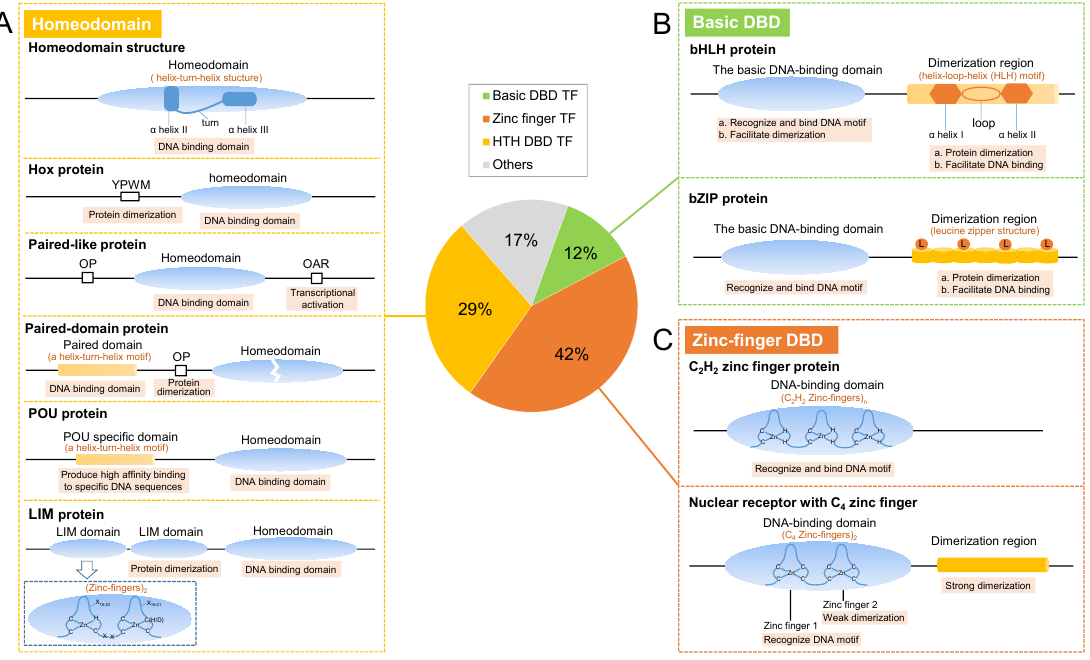
Figure 2. The main structures of insect TFs. The pie chart represents the statistical ratio of the Drosophila TFs in different superclasses based on Hammonds’ study [22]. ( A ) Structures of homeodomain TFs. Homeodomain: a typical homeodomain contains a short N-terminal arm facilitating DNA binding and four α -helices with a helix II-turn-helix III structure that is responsible for DNA binding and recognition; Hox protein: in addition to the homeodomain, a Hox protein typically contains a YPWM motif in the N-terminus mediating protein dimerization; Paired-like protein: in addition to the homeodomain, some paired-like proteins include an N-terminal octapeptide (OP) motif, and some contain a C-terminal OAR motif that can be involved in transcriptional activation; Paired-domain protein: paired-domain proteins carry an N-terminal paired box with a helix-turn-helix (HTH) structure that mediates DNA binding, and some proteins have a full-length or truncated homeodomain in the C-terminus, as well as an OP motif between the paired box and the homeodomain to mediate protein dimerization; POU (Pit-Oct-Unc) protein: POU proteins have a POU-specific domain with an HTH structure in the N-terminus that contributes to the generation of high-affinity DNA binding, and the homeodomain in the C-terminus is responsible for DNA binding; LIM protein: LIM proteins possess two LIM domains with zinc finger (ZF) structures upstream of the homeodomain that mainly mediate protein-protein interactions. ( B ) Structures of basic DBD TFs. The basic leucine zipper (bZIP) protein: bZIP proteins harbor a